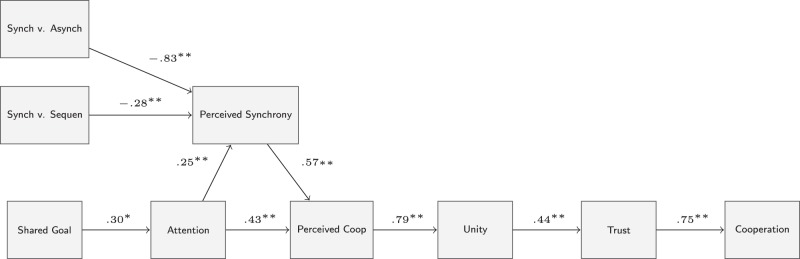
The reinforcement of cooperation model.(1) Movement manipulation: the creation of synchrony (synch) leads to greater perceived synchrony amongst the performers compared to asynchronous (asynch) or sequential (sequen) movement. (2) Goal manipulation: having a shared goal to coordinate movement in a certain way results in greater attention to the other participants’ movements. When a shared goal and synchrony are combined, this further strengthens perceived synchrony. Perceiving synchrony when there is a shared goal to produce synchrony provides immediate feedback of successful cooperation in performing the synchronous task together so increasing perceived cooperation. Increased feelings of successful cooperation lead to perceptions of social unity, from which participants feel greater trust and confidence that their fellow participants will cooperate in the future. Greater trust leads to greater cooperation in future interactions. Numbers above arrows represent standardised coefficients (* p<.05; ** p<.01).